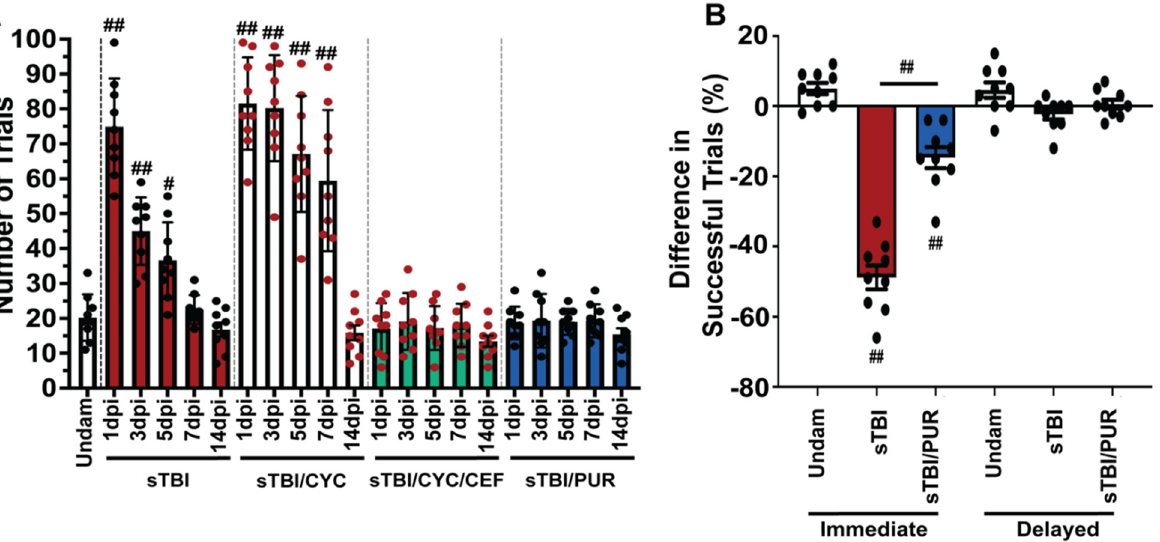
Figure 6. Cognitive impairments are attenuated by prophylactic Shh activation. ( A ) Histogram quantifying the number of trials required for associative learning assay of undamaged and either untreated or Shh-modulated sTBI fish at 1, 3, 5, 7 and 14 dpi ( n = 9 fish per control/experimental group). ( B ) Quantification of immediate and delayed recall of undamaged, sTBI, and sTBI/PUR fish ( n = 9 fish per control/experimental group). Statistical analyses were performed with a one-way ANOVA followed by Tukey’s multiple comparison post hoc test, # p < 0.05, ## p < 0.01.